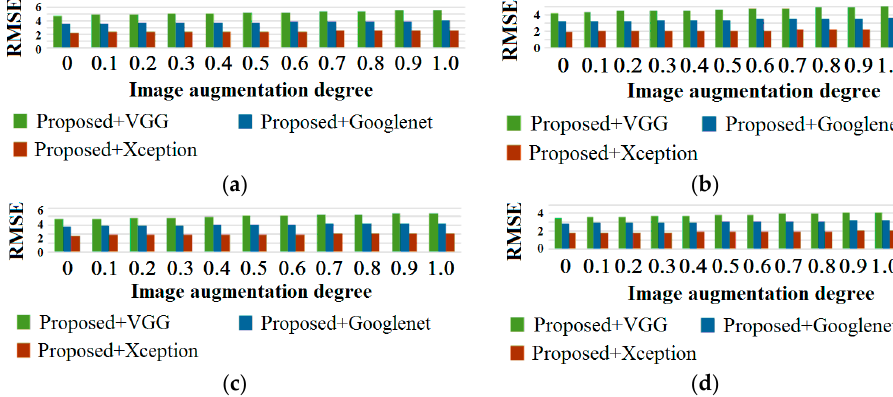
Figure 6. Robustness of the proposed algorithm under different perturbation values and CNNs: ( a ) ρ = 36; ( b ) ρ = 32; ( c ) ρ = 28; ( d ) ρ = 24.